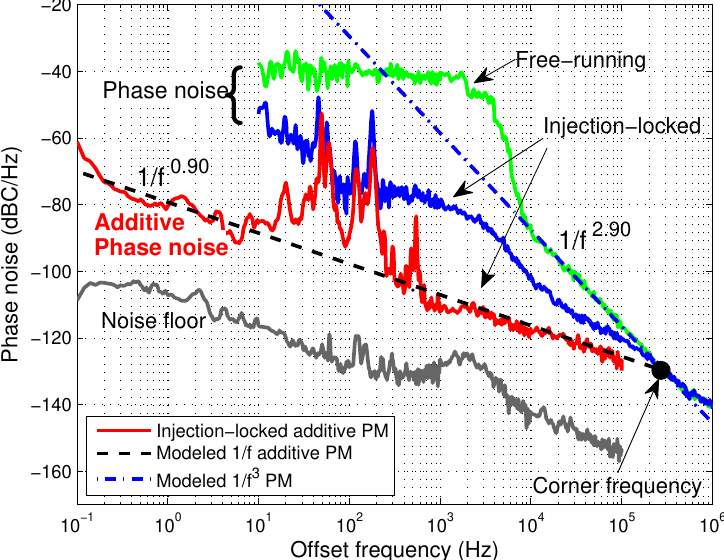
Figure 9. Comparison of additive phase noise S φ , add and phase noise S φ for the pHEMT oscillator with Load Circuit 1 operating at 2.4828 GHz.